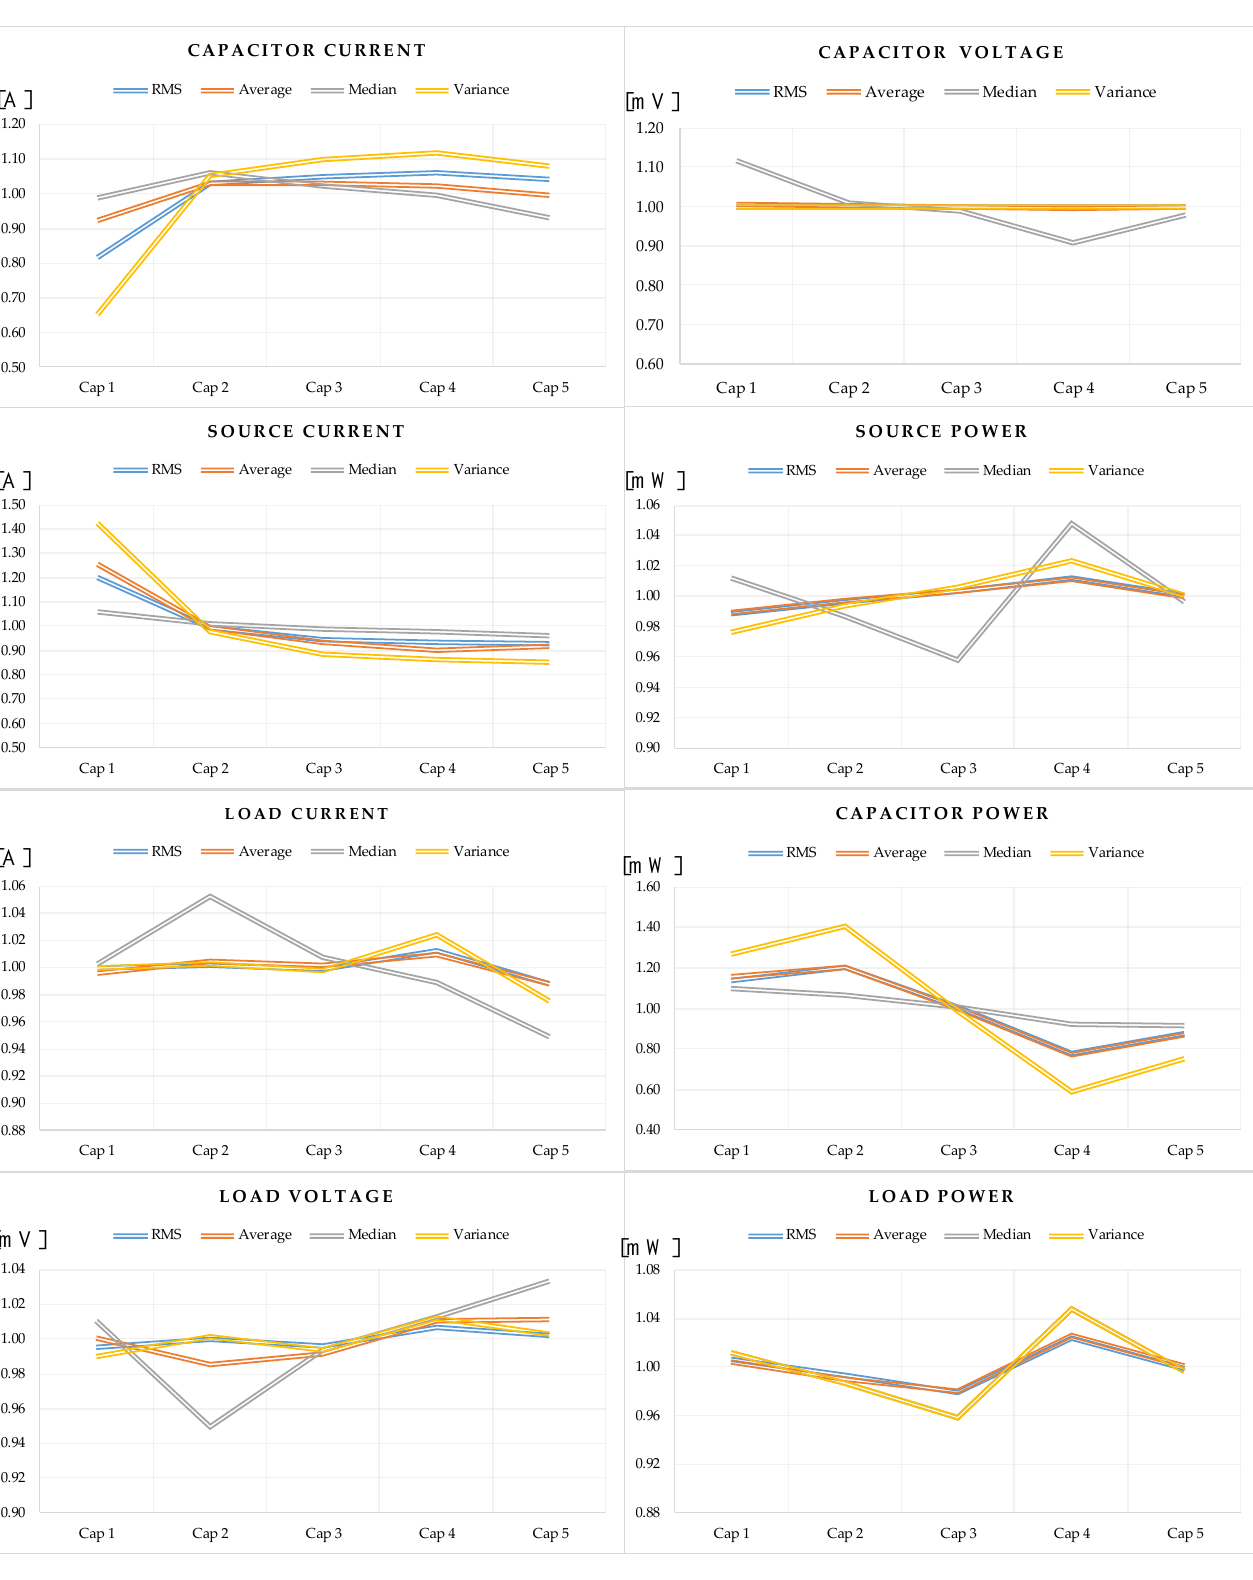
Figure 6. Normalized indexes (RMS, average, median, and variance) of different input signals using FFT analysis.